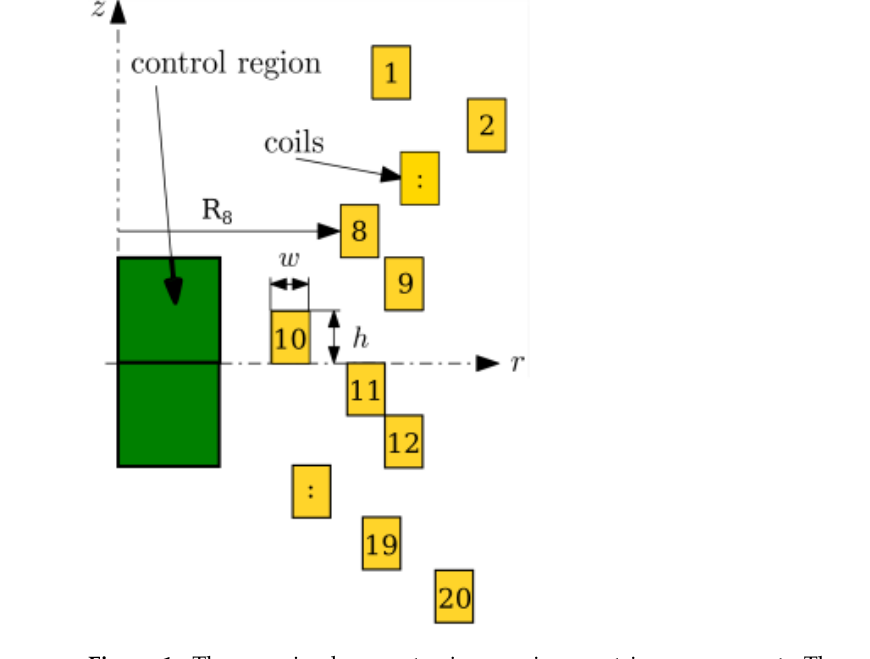
Figure 1. The examined geometry in an axisymmetric arrangement. The green area shows the controlled region in which the magnetic field is considered. Every single turn of the coil is denoted by yellow rectangles; their radii are optimized turn by